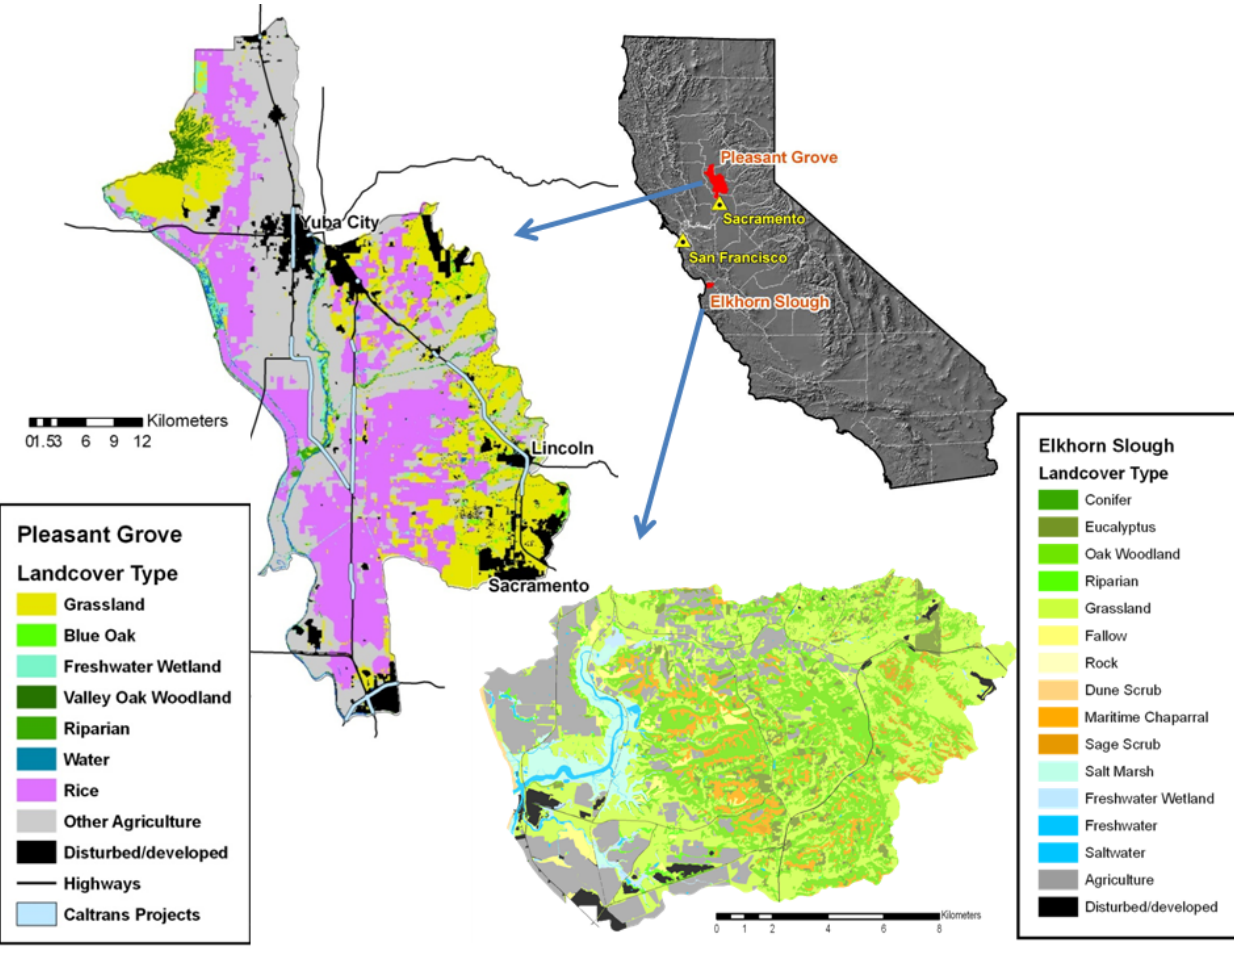
Fig. 2. Location of the Elkhorn Sough and Pleasant Grove study areas. Study-area insets show the land- cover maps used for each study. The Elkhorn Slough study-area map was derived from high-resolution aerial photography, the Pleasant Grove map selected from a state-wide, satellite-image-based